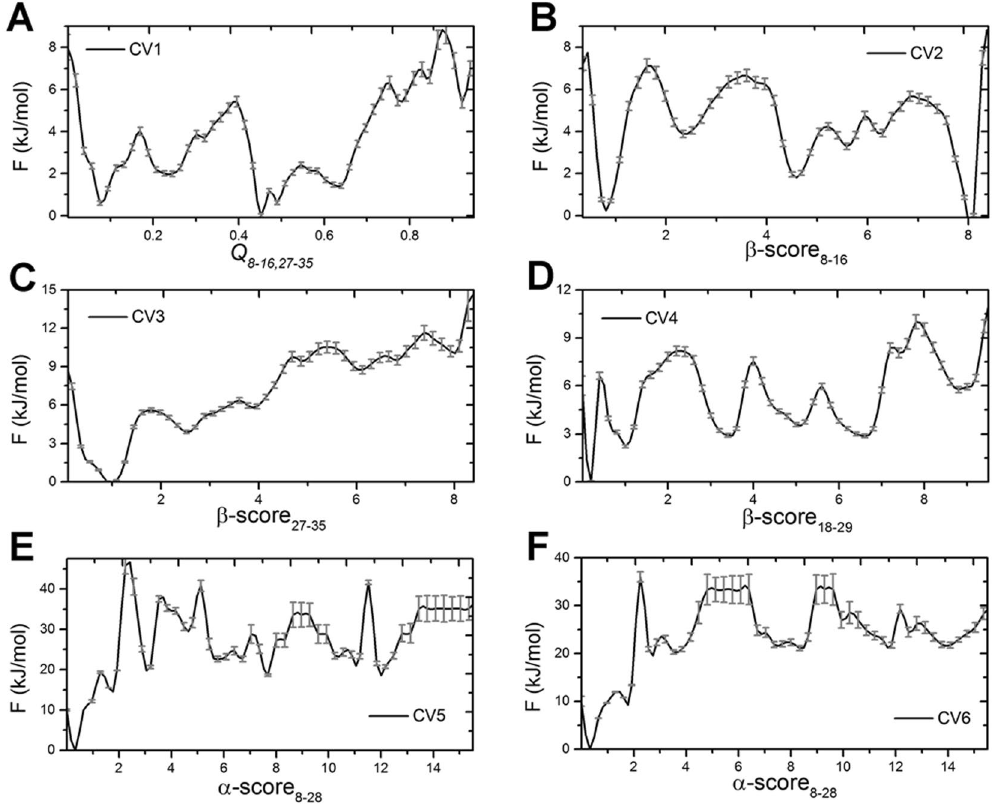
Figure 1. Free energy profiles as function of collective variables. ( A ) Q value for segment 8–16 and 27–35 on the two peptides; ( B ) β -score of segment 8–16; ( C ) β -score of segment 27–35; ( D ) β -score of segment 18–29; ( E ) α -score of segment 8–26 of chain A; ( F ) α -score of segment 8–26 of chain B. The error bars corresponding to the free energy deviation over the last 300 ns of simulations, which were calculated by following the method in ref.